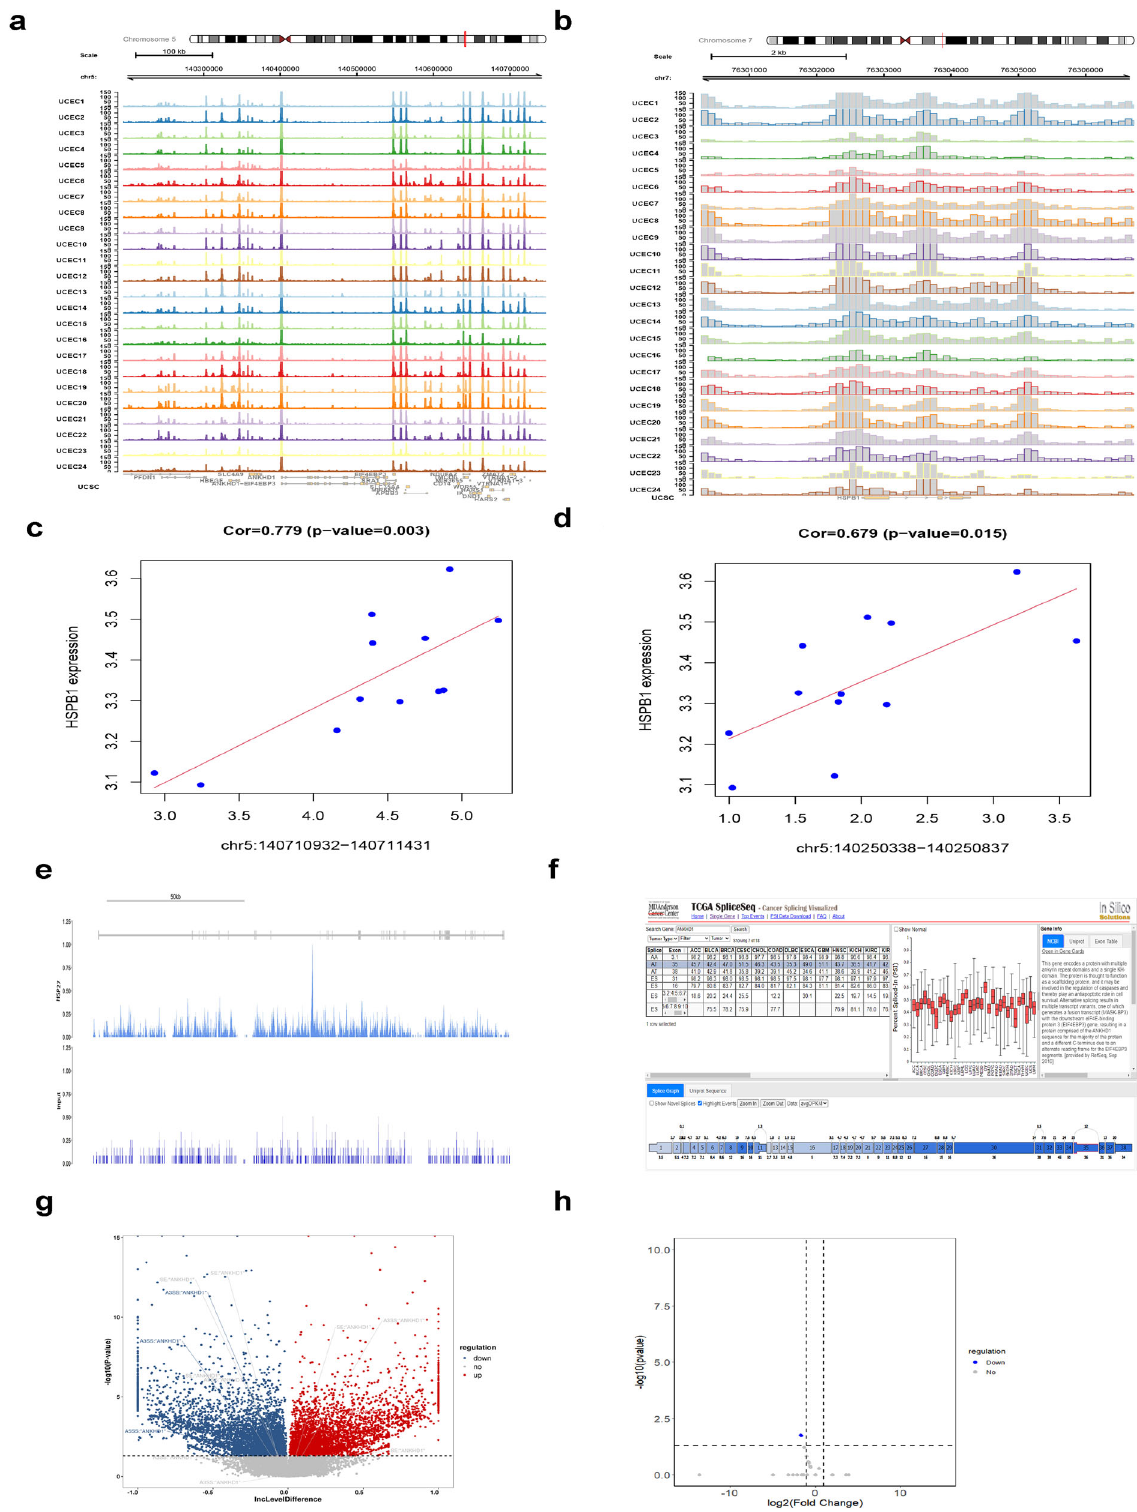
Fig. 4 Direct AS mechanism validation of ANKHD1. ATAC-seq of HSPB1 ( a ) and ANKHD1 ( b ). The correlation of HSPB1 and the chromatin accessibility of ANKHD1 ( c , d ). Chip-seq of HSPB1 ( e ) in HEC-1b cells. The splicing pattern plot ( f ). Overexpression of HSPB1 generated ASEs ( g ) and ANKHD1-BP3 ( h